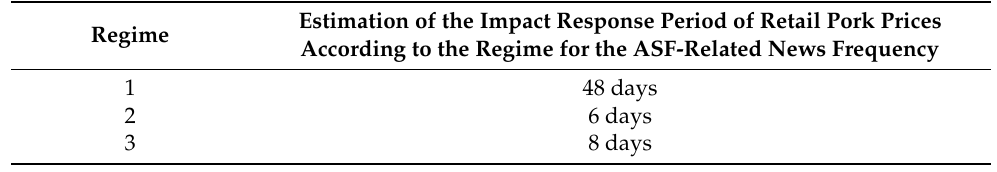
Table 5. Estimation of the Impact Response Period of retail pork prices according to the regime for ASF-related news frequency.